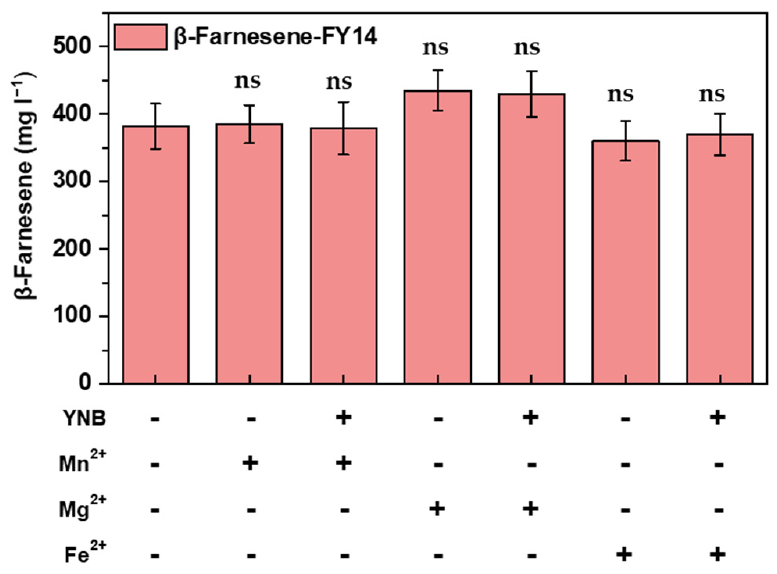
Figure 7. Effect of adding YNB and metal ions on β -farnesene production. β -Farnesene was detected at 96 h of fermentation. Data are represented as mean ± standard deviation (n = 3). Statistically significant differences between each engineered β -farnesene production strain and control strain (NC) are noted (two-tailed t -test; ns—not significant).